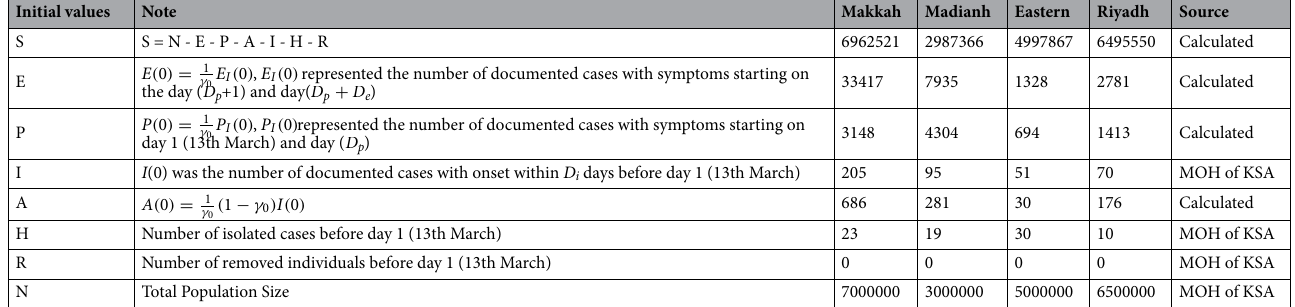
Table 2. Notations of compartments and the initial conditions by region for the main